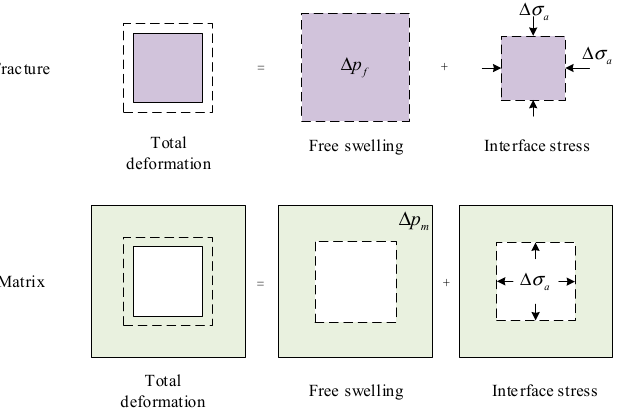
Figure 2. Schematic diagram of the compressive stress state.